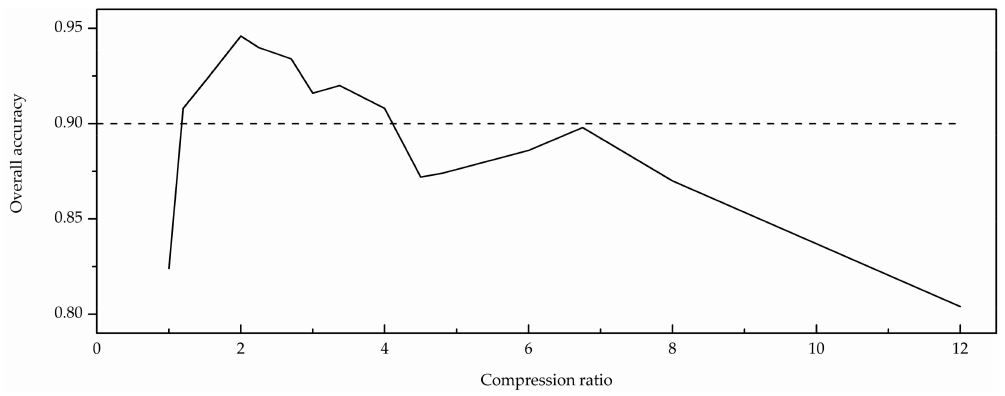
Figure 6. Overall accuracy with the compression ratio